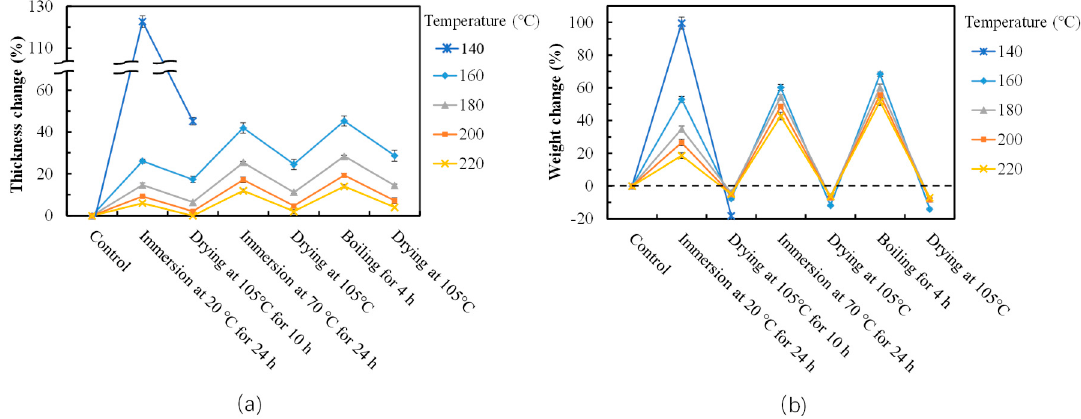
Figure 4. Thickness change ( a ) and weight change ( b ) during cyclic aging treatment of the particleboards bonded with SADP 85/15 adhesives with different hot pressing temperatures. Error bars indicate the standard deviations.